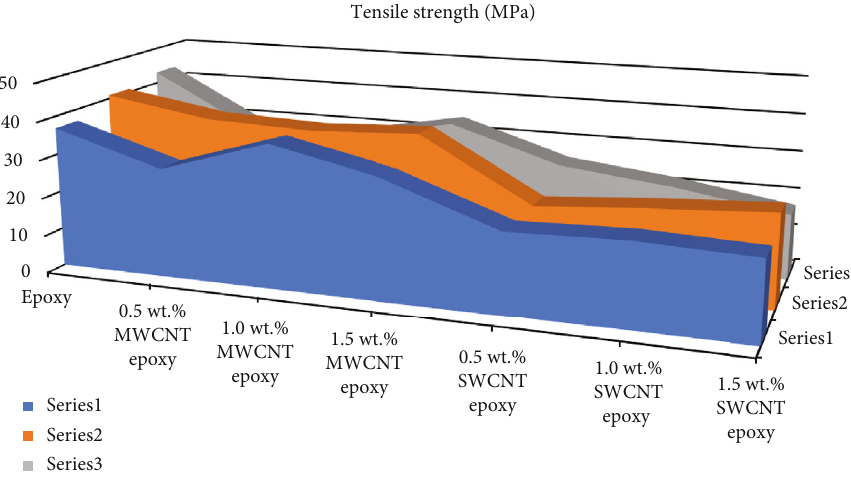
Figure 5: Average tensile strength results for CNT-epoxy composite specimens obtained from the tension